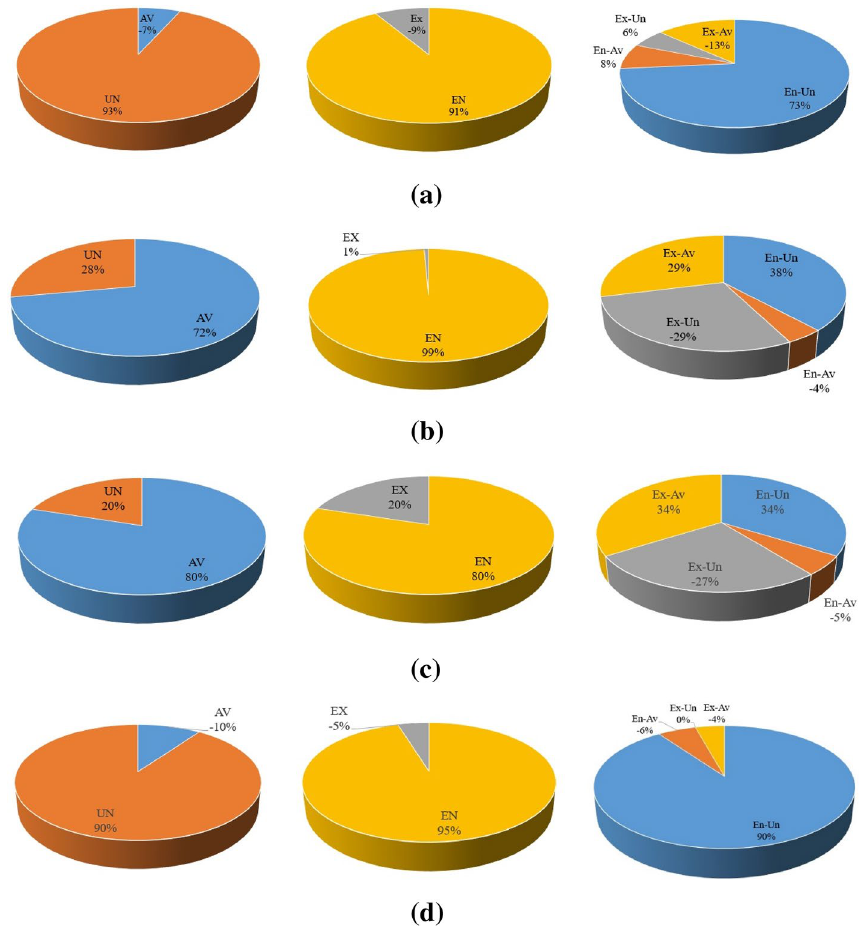
Fig. 4 Splitting exergy destruction rates of components: a Expansion valve, b steam turbine, c pump, and d